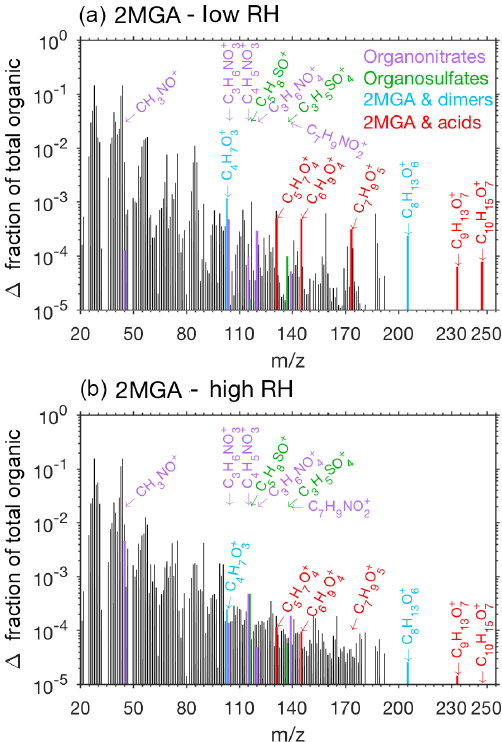
Figure 9. High-resolution AMS organic mass spectra (averaged over 10h of photooxidation – the sulfate background) for experi- ment D3 (RH = 8%, panel a ) and D9 (RH = 78%, panel b ) in gray. Fragments are labeled as 2-MGA monomer or dimer (cyan), ester- ification of 2-MGA with acids (red), isoprene epoxydiol (IEPOX) tracers (dark green), and examples of organonitrate fragments – C x H y NO z (purple).